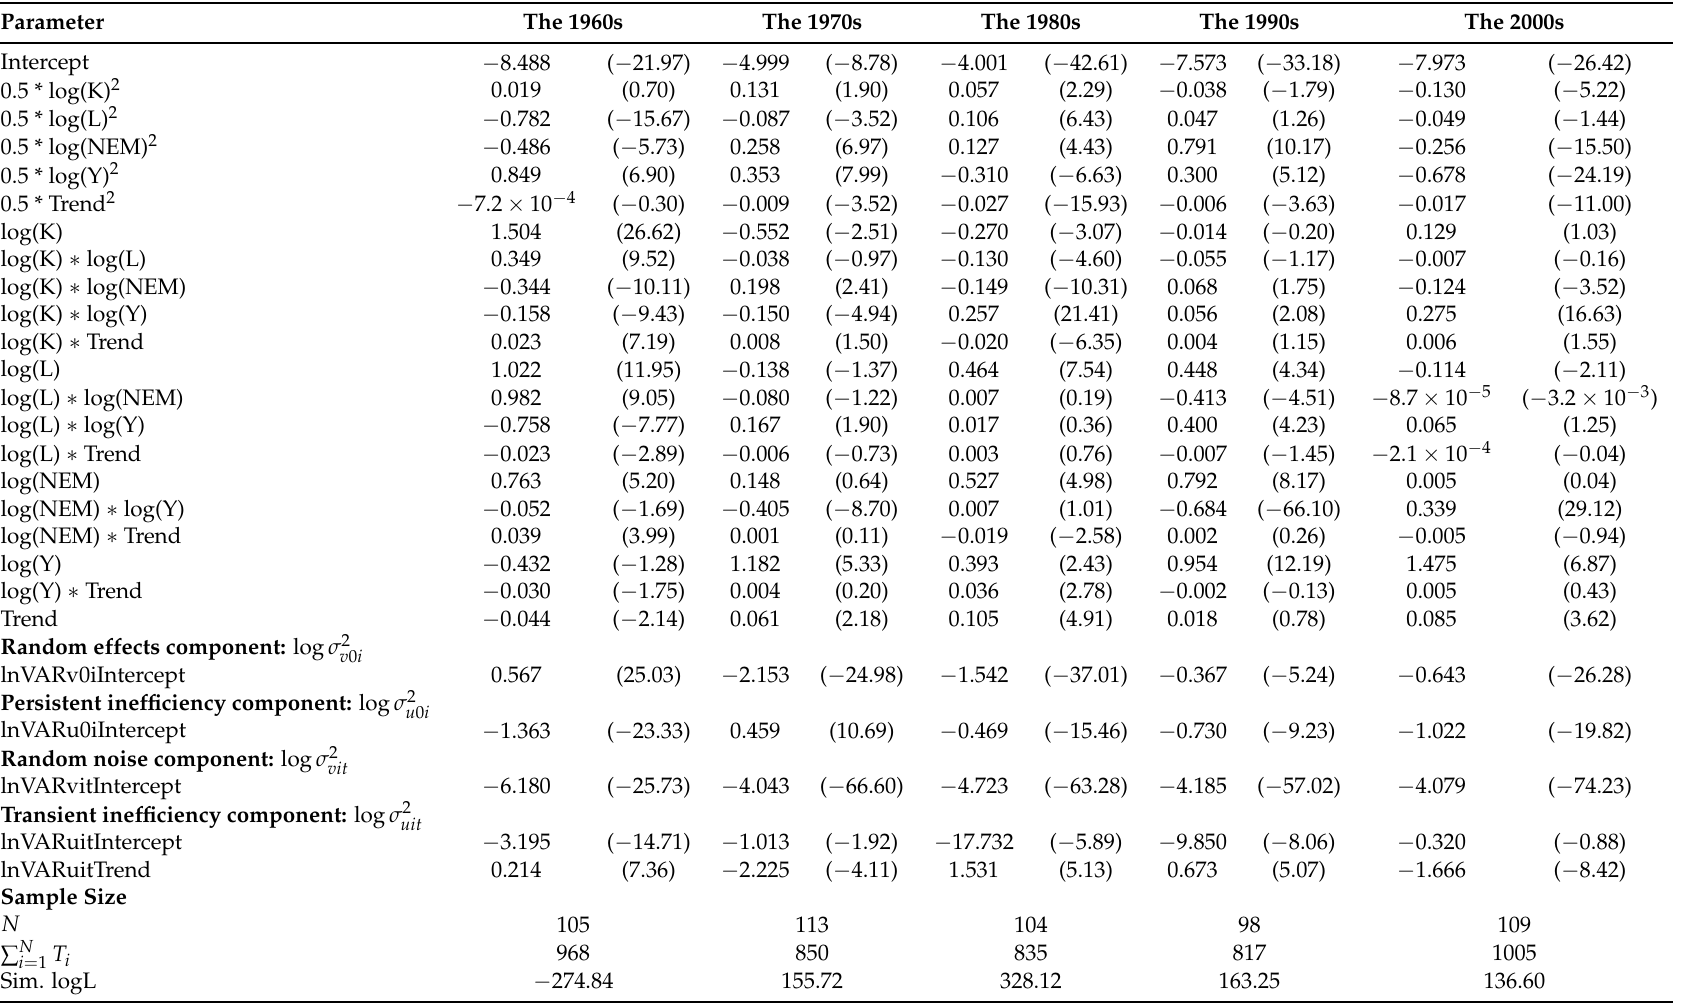
Table 3. Model 2 as in Equation (8). Dependent variable is log E . z -values in